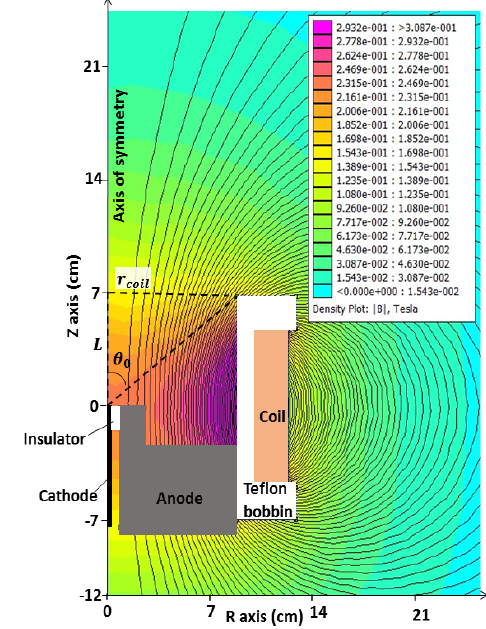
Figure 3. R-Z cross section of the thruster and magnetic coil showing calculated field lines. Magnetic induction calculated for I coil = 105 A is indicated by background color. r coil and L are the inner radius and blocked length of the